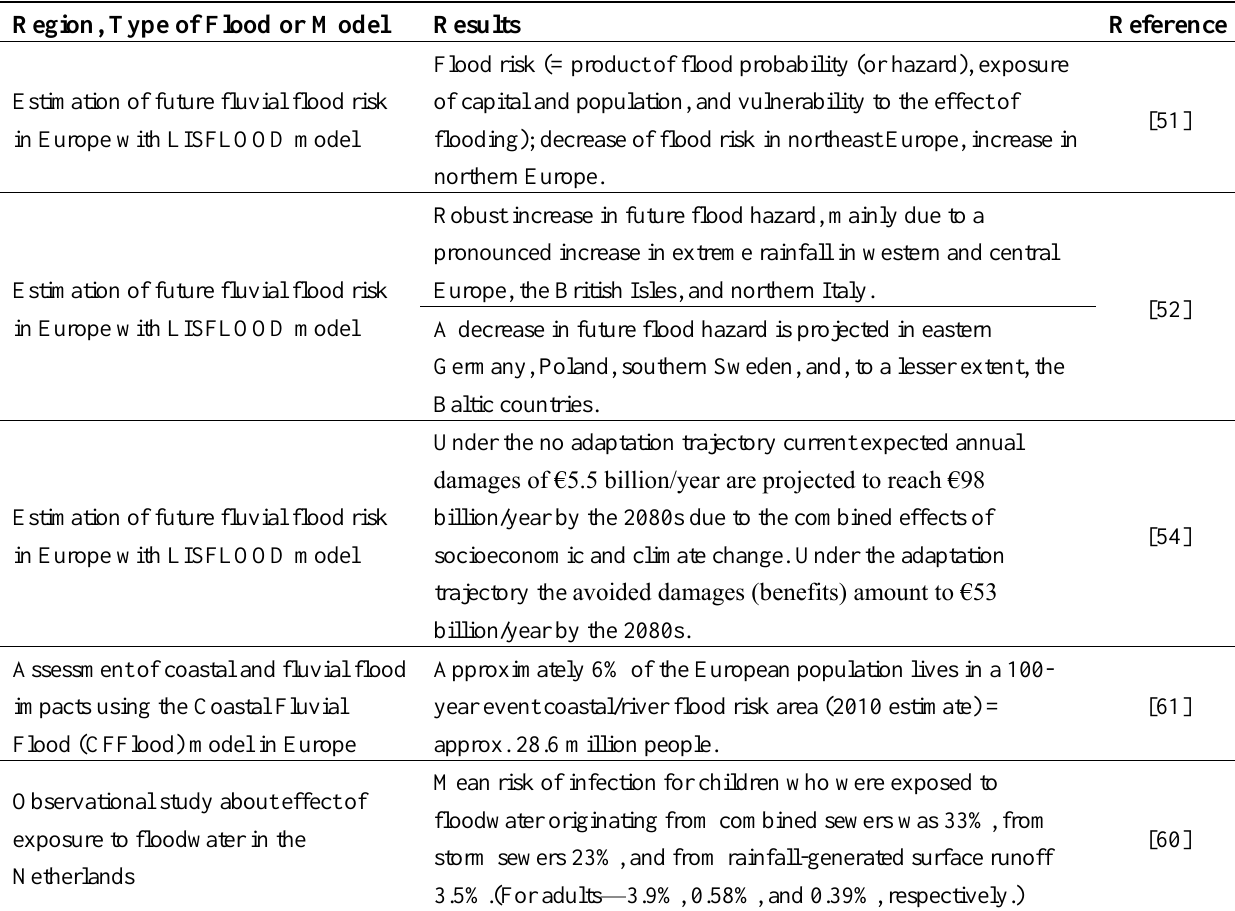
Table 4 . Search results of literature about health effects from flooding